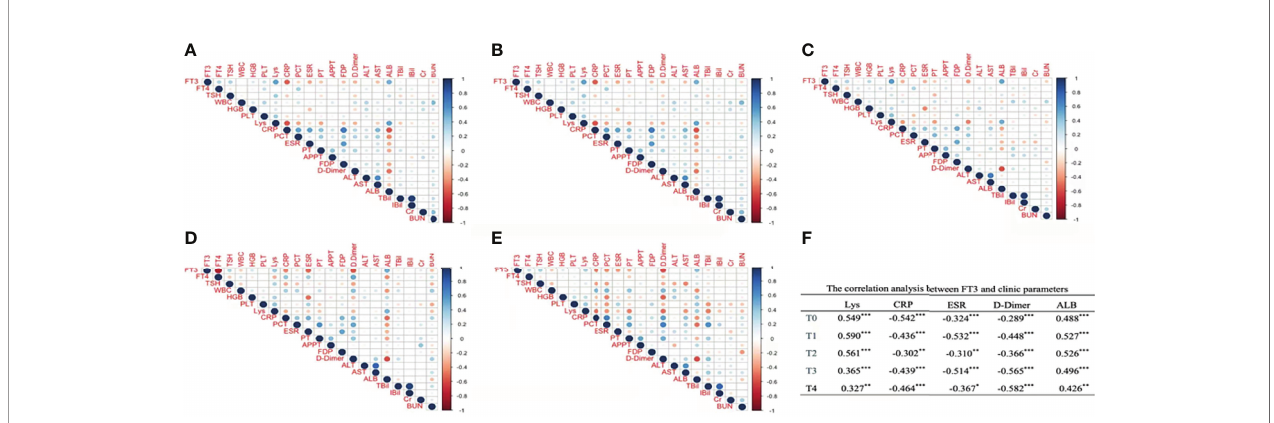
FIGURE 1 | The correlation analysis between FT3 and clinic parameters at different time points after admission. Panel (A) corresponds to T0, Panel (B) corresponds to T1, Panel (C) corresponds to T2, Panel (D) corresponds to T3, Panel (E) corresponds to T4. (A – E) Digits represents Pearson correlation coef fi cients, fi lled color indicates signi fi cant correlation, blue represents positive correlation, red represents negative correlation, and shade of color represents strength of correlation). FT3, free triiodothyronine; FT4, free thyroxine; WBC, white blood cell; HGB, hemoglobin; PLT, platelet; Lys, lymphocytes; CRP, C-reactive protein; PCT, procalcitonin; ESR, erythrocyte sedimentation rate; PT, prothrombin time; APTT, activated partial thromboplastin time; FDP, fi brin degradation product; ALT, alanine aminotranspherase; AST, aspartate aminotransferase; Alb, albumin; TBil, total bilirubin; IBil, indirect bilirubin; Cr, serum creatinine; BUN, urea nitrogen. (F) * p < 0.05, ** p < 0.01, *** p <